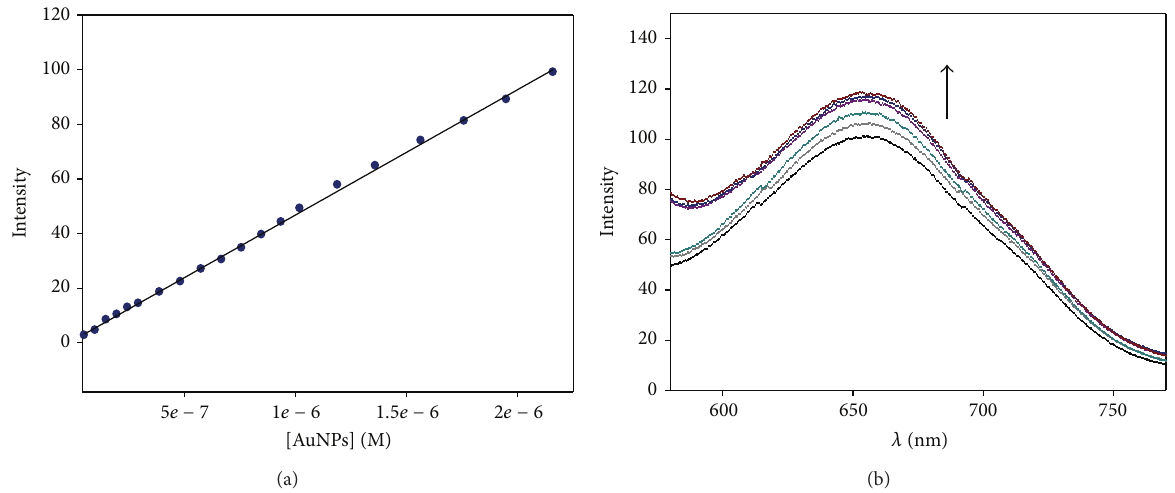
Figure 1: (a) Plot of fluorescence intensity at 656 nm of Au@tiopronin versus [AuNPs], in the absence of DNA. (b) Fluorescence spectra of AuNPs/DNA system recorded for increasing concentrations of DNA in 5% of ethanol. [AuNPs] = 1.5 × 10 −6 M; [DNA] = 0 M (bottom); [DNA] = 7 × 10 −5 M (top).